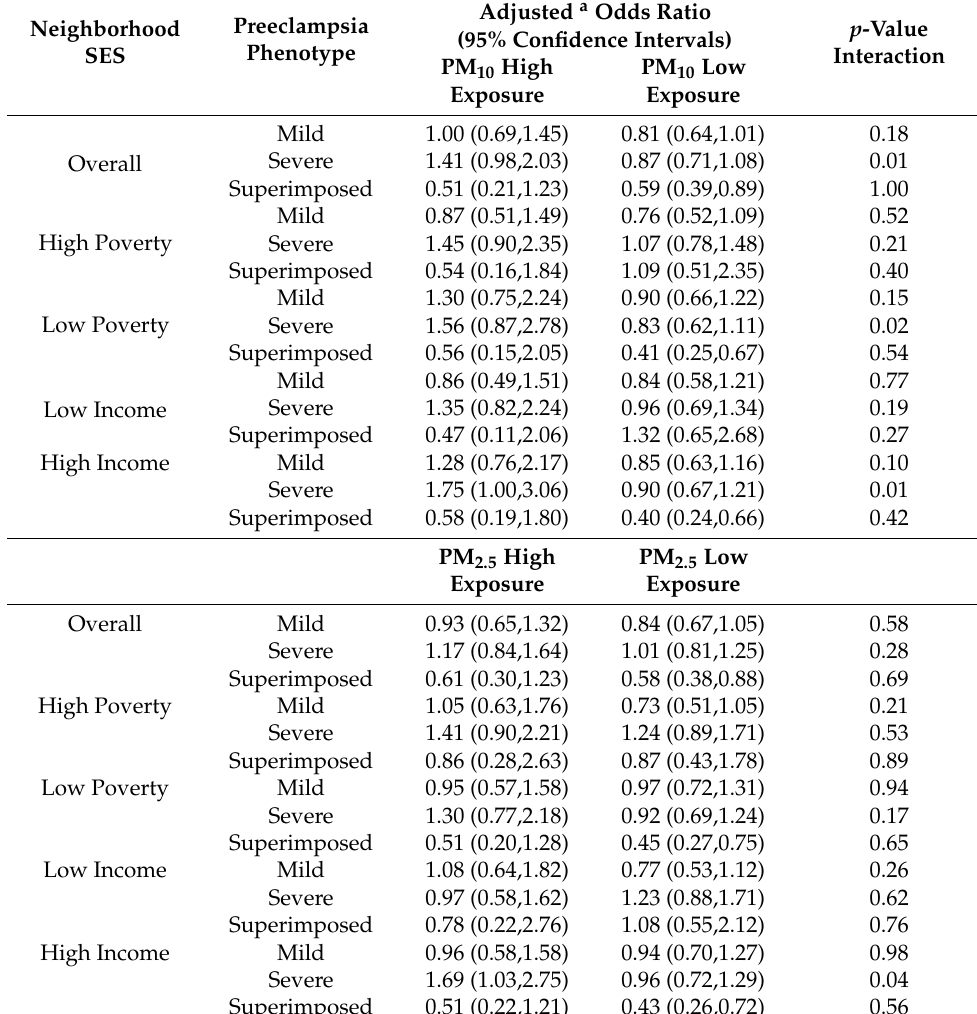
Table 5. Associations between greenspace (average NDVI) within a 500 m buffer surrounding partici- pant residence by level of exposure to PM 10 and PM 2.5 , as well as by pollutant and neighborhood SES factors from 2000 to